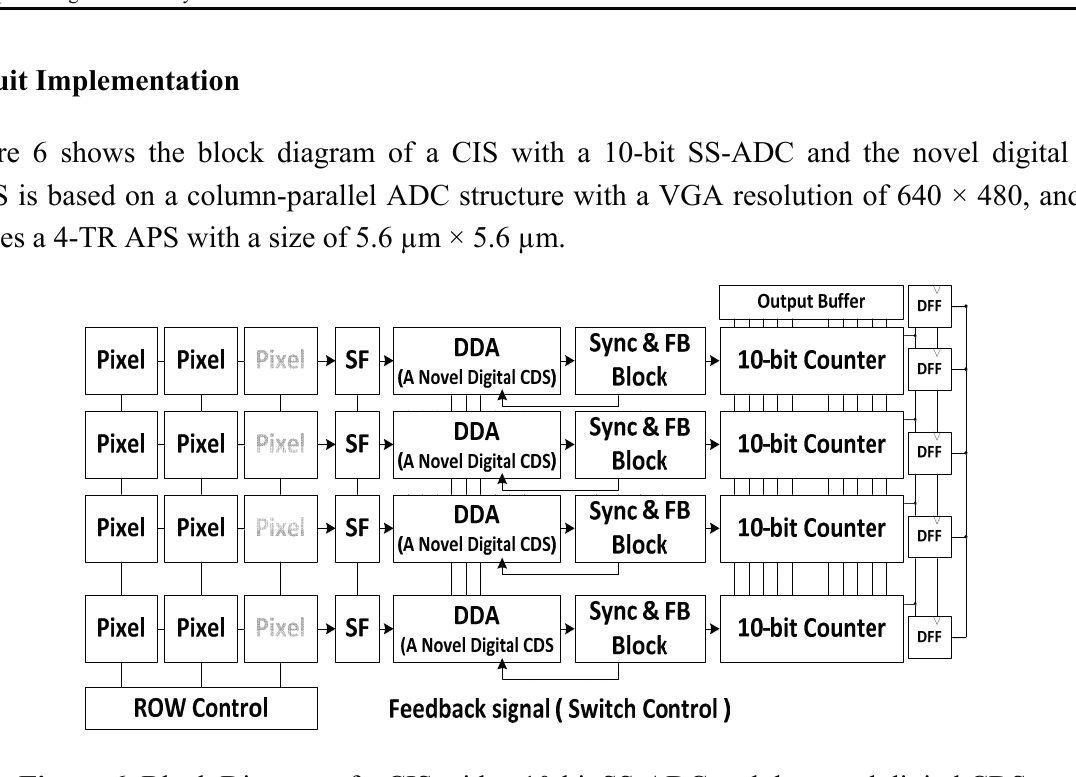
Figure 6. Block Diagram of a CIS with a 10-bit SS-ADC and the novel digital